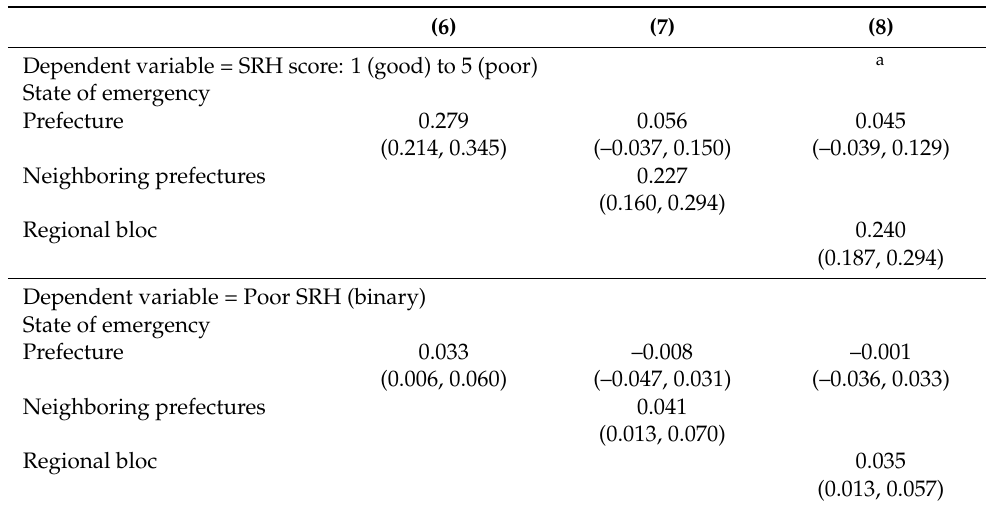
Table 5. Estimated association between the state of emergency and self-rated health (SRH) a ( N = 4520 observations of 2260